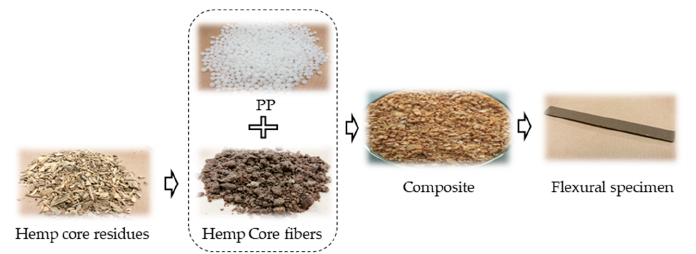
Figure 2. Illustrations of the raw materials (polypropylene PP ISPLEN 090 GDM (PP), hemp core), hemp core fibers after being treated, composite material and flexural specimen 2.2.3. Three-point bending test.